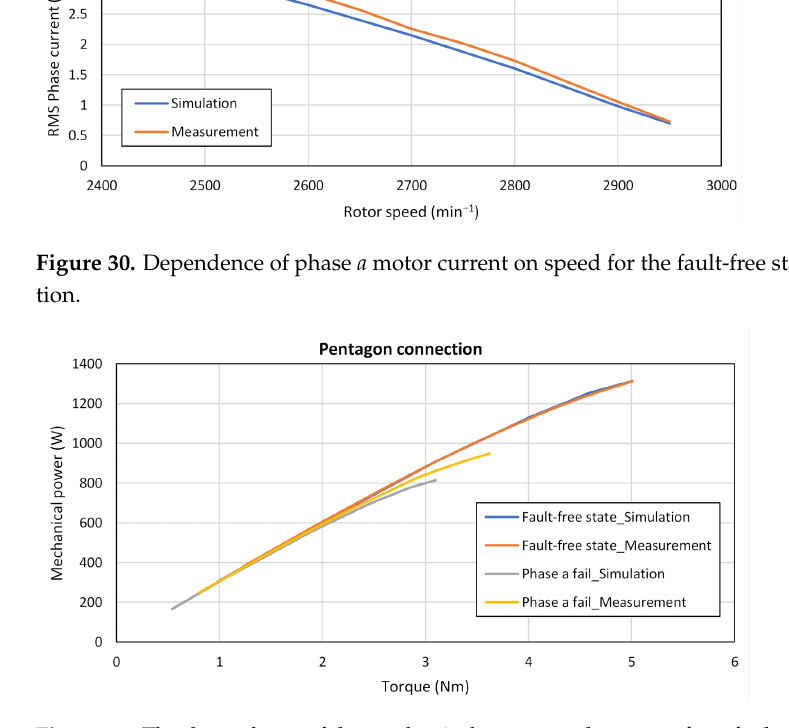
Figure 31. The dependence of the mechanical power on the torque for a fault-free state and one phase failure in the pentagon connection.